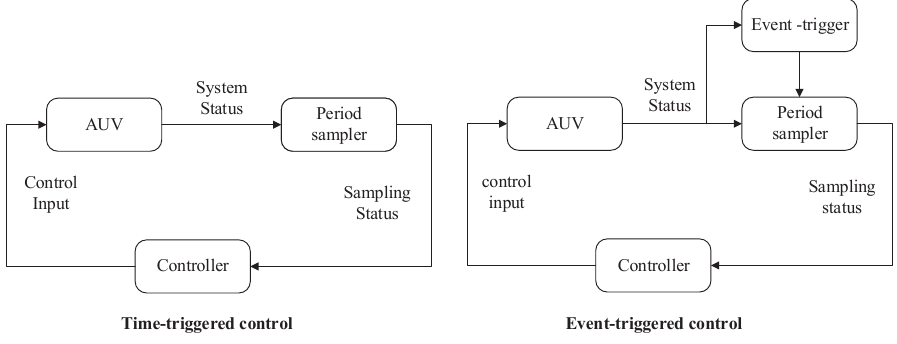
Figure 1. The difference between event-triggered and